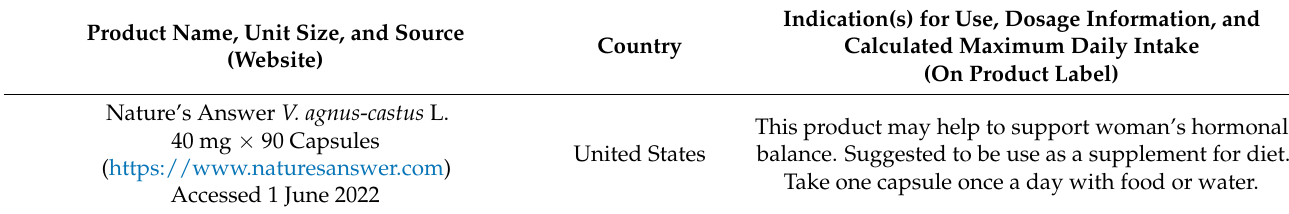
Table 3. Information on Vitex products available in the